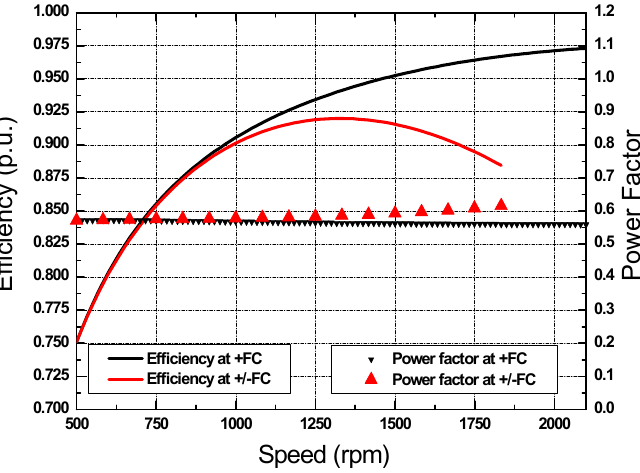
World Electric Vehicle Journal 2020 , 11 , x FOR PEER REVIEW 11 of 17